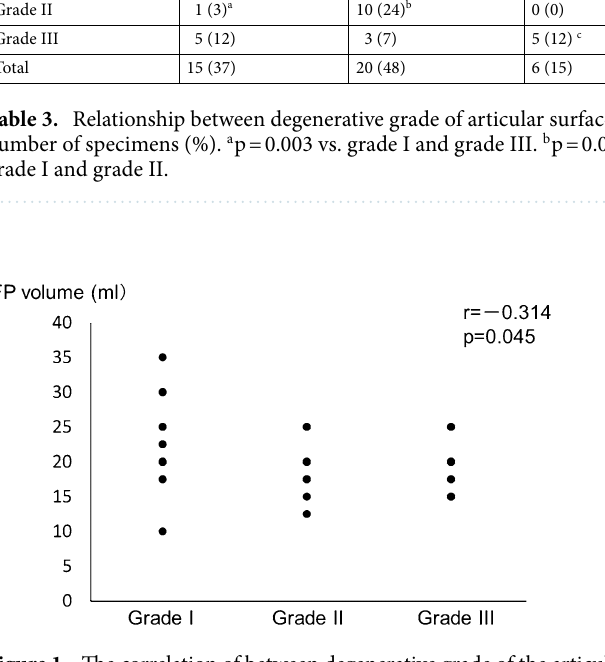
Figure 1. The correlation of between degenerative grade of the articular surface of the patella and IFP volume. Grade I: macroscopically intact or only mildly altered; Grade II: macroscopically moderately altered (if fissuring or fibrillation is observed); Grade III: macroscopically severely altered (if eburnation is